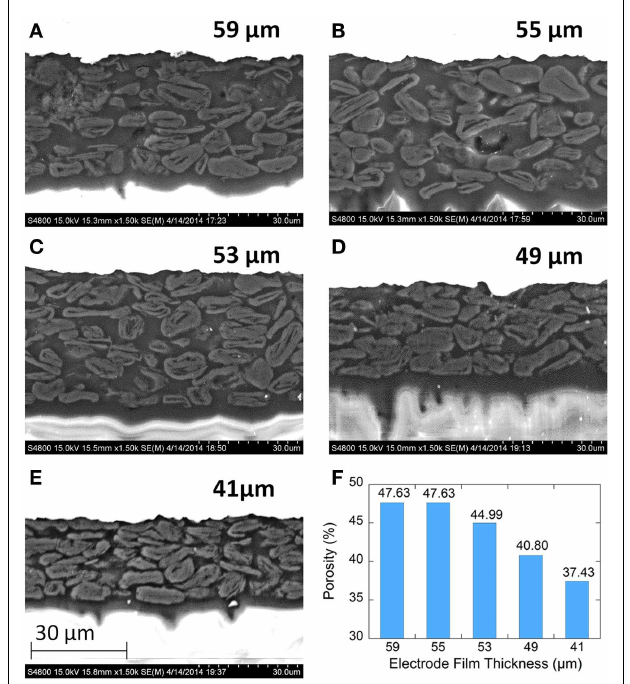
FIGURE 4 | Cross-sectional backscattered electron (BSE) SEM images of graphite anode electrodes films . (A–E) are for 59, 55, 53, 49, and 41 µ m, respectively. (F) Porosity for each film as measured by